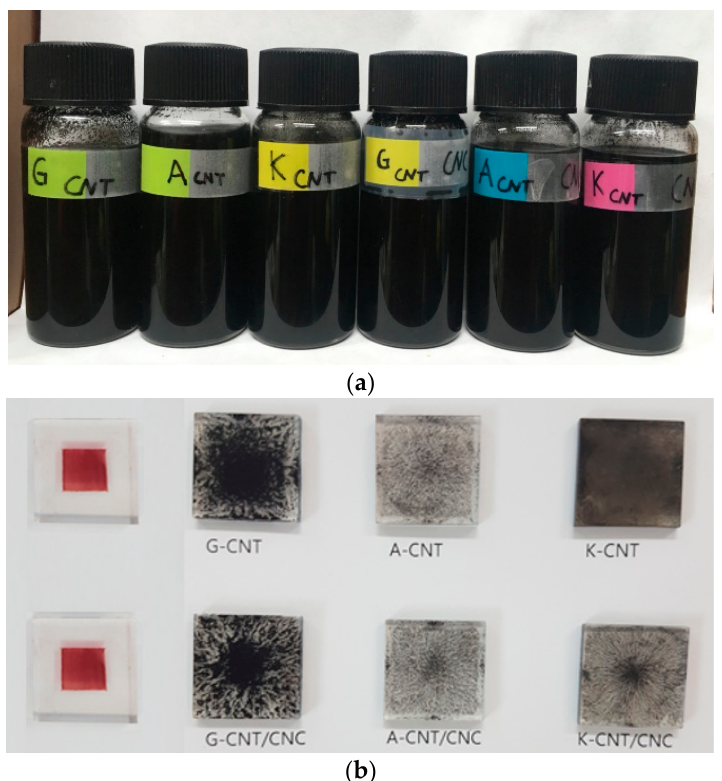
Figure 1. Photos of the sample (Ground CNT, A-Ground CNT, K-Ground CNT, Ground CNT / CNC, A-Ground CNT / CNC, K-Ground CNT / CNC): ( a ) Photo of the solution samples, ( b ) TiO 2 electrode